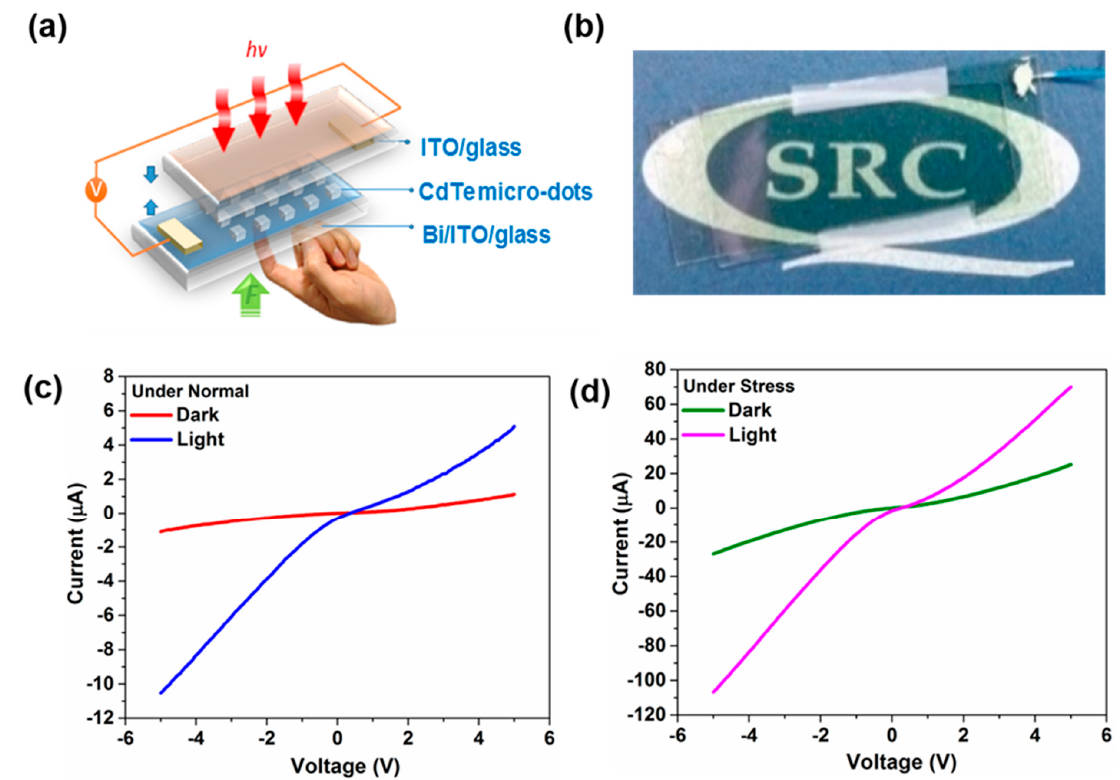
Figure 7. ( a ) Schematic of CdTe microdots array photodetectors; ( b ) Digital photographical image of a typical device; ( c ) Current-voltage (I–V) curve of the CdTe microdots array photodetectors under normal conditions in dark and illumination; ( d ) I–V characteristics of the device under stress (pressing condition) in dark and illumination.